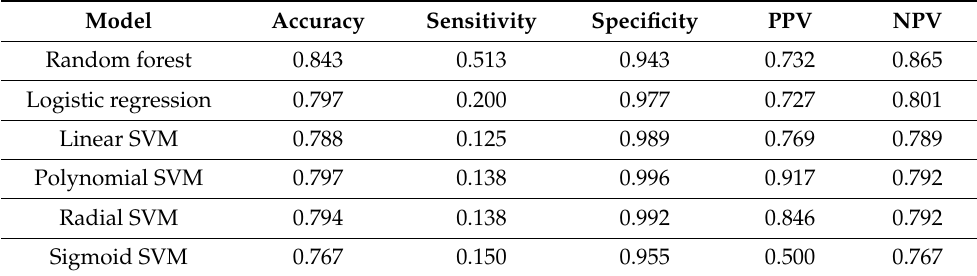
Table 3. Comparison of Performance of Prediction Models.